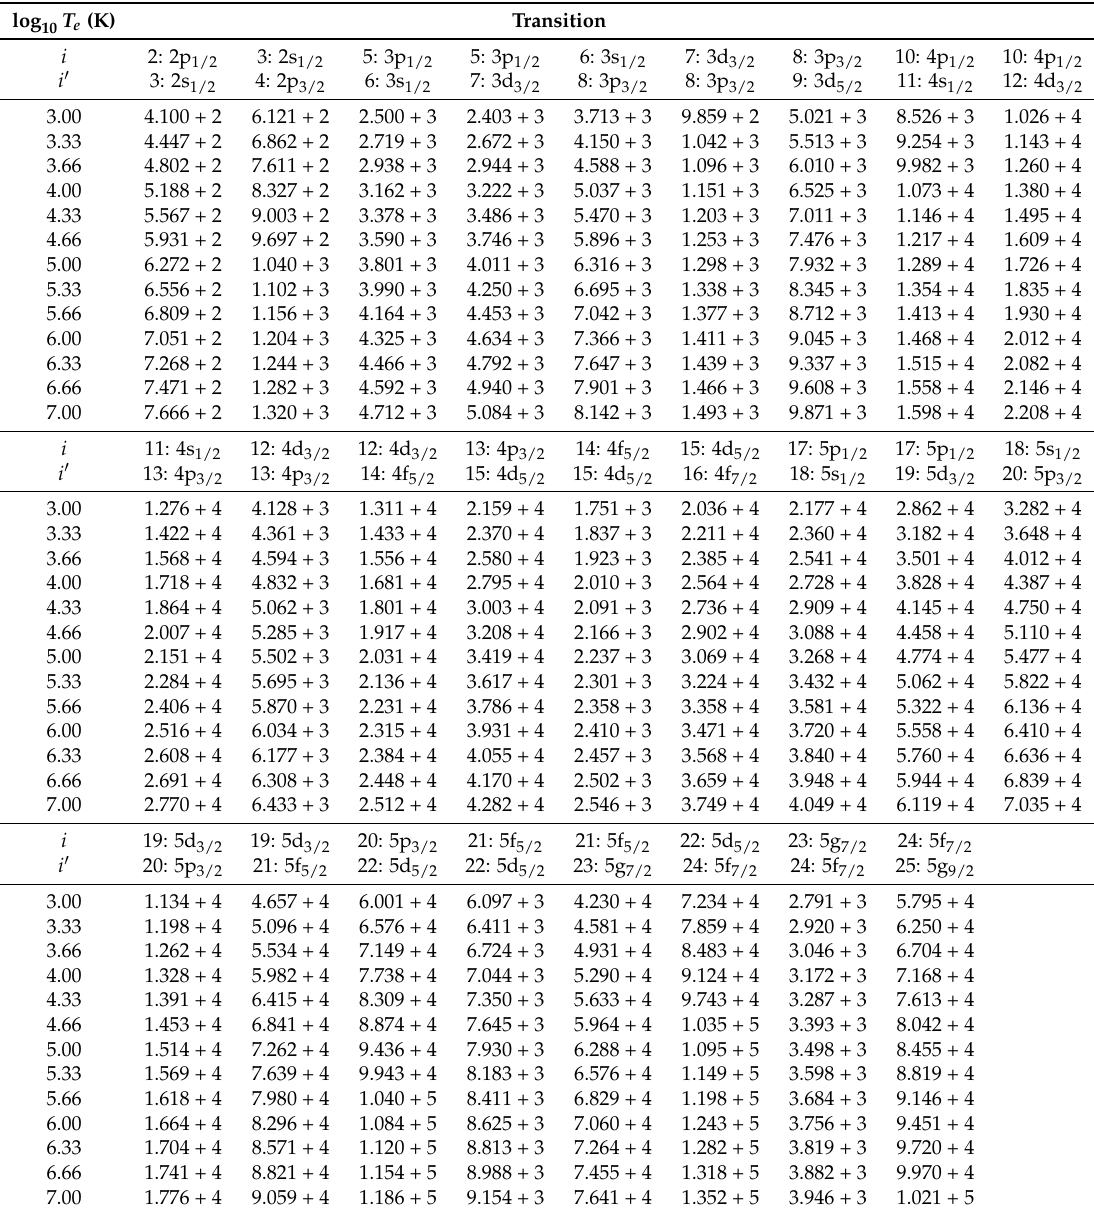
Table 3. Effective collision strengths for transitions of atomic hydrogen as function of